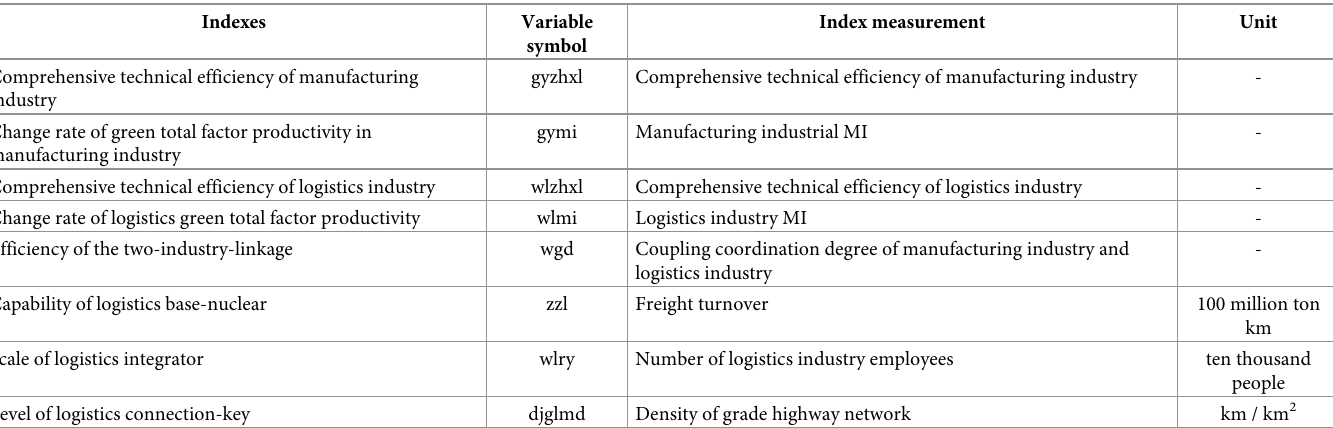
Table 2. PVAR model index description.